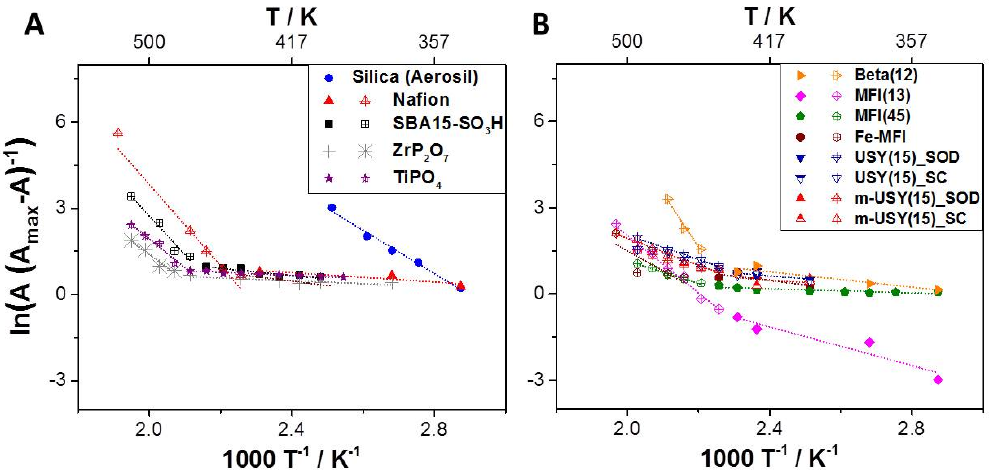
Figure 3. ( A ) VTIR plots for H/D-exchange on different typical proton-conducting materials and ( B ) ff erent zeolites with di ff erent topologies, Si / Al ratios, and for different zeolites with different topologies, Si/Al ratios, and micro–mesoporosity. di